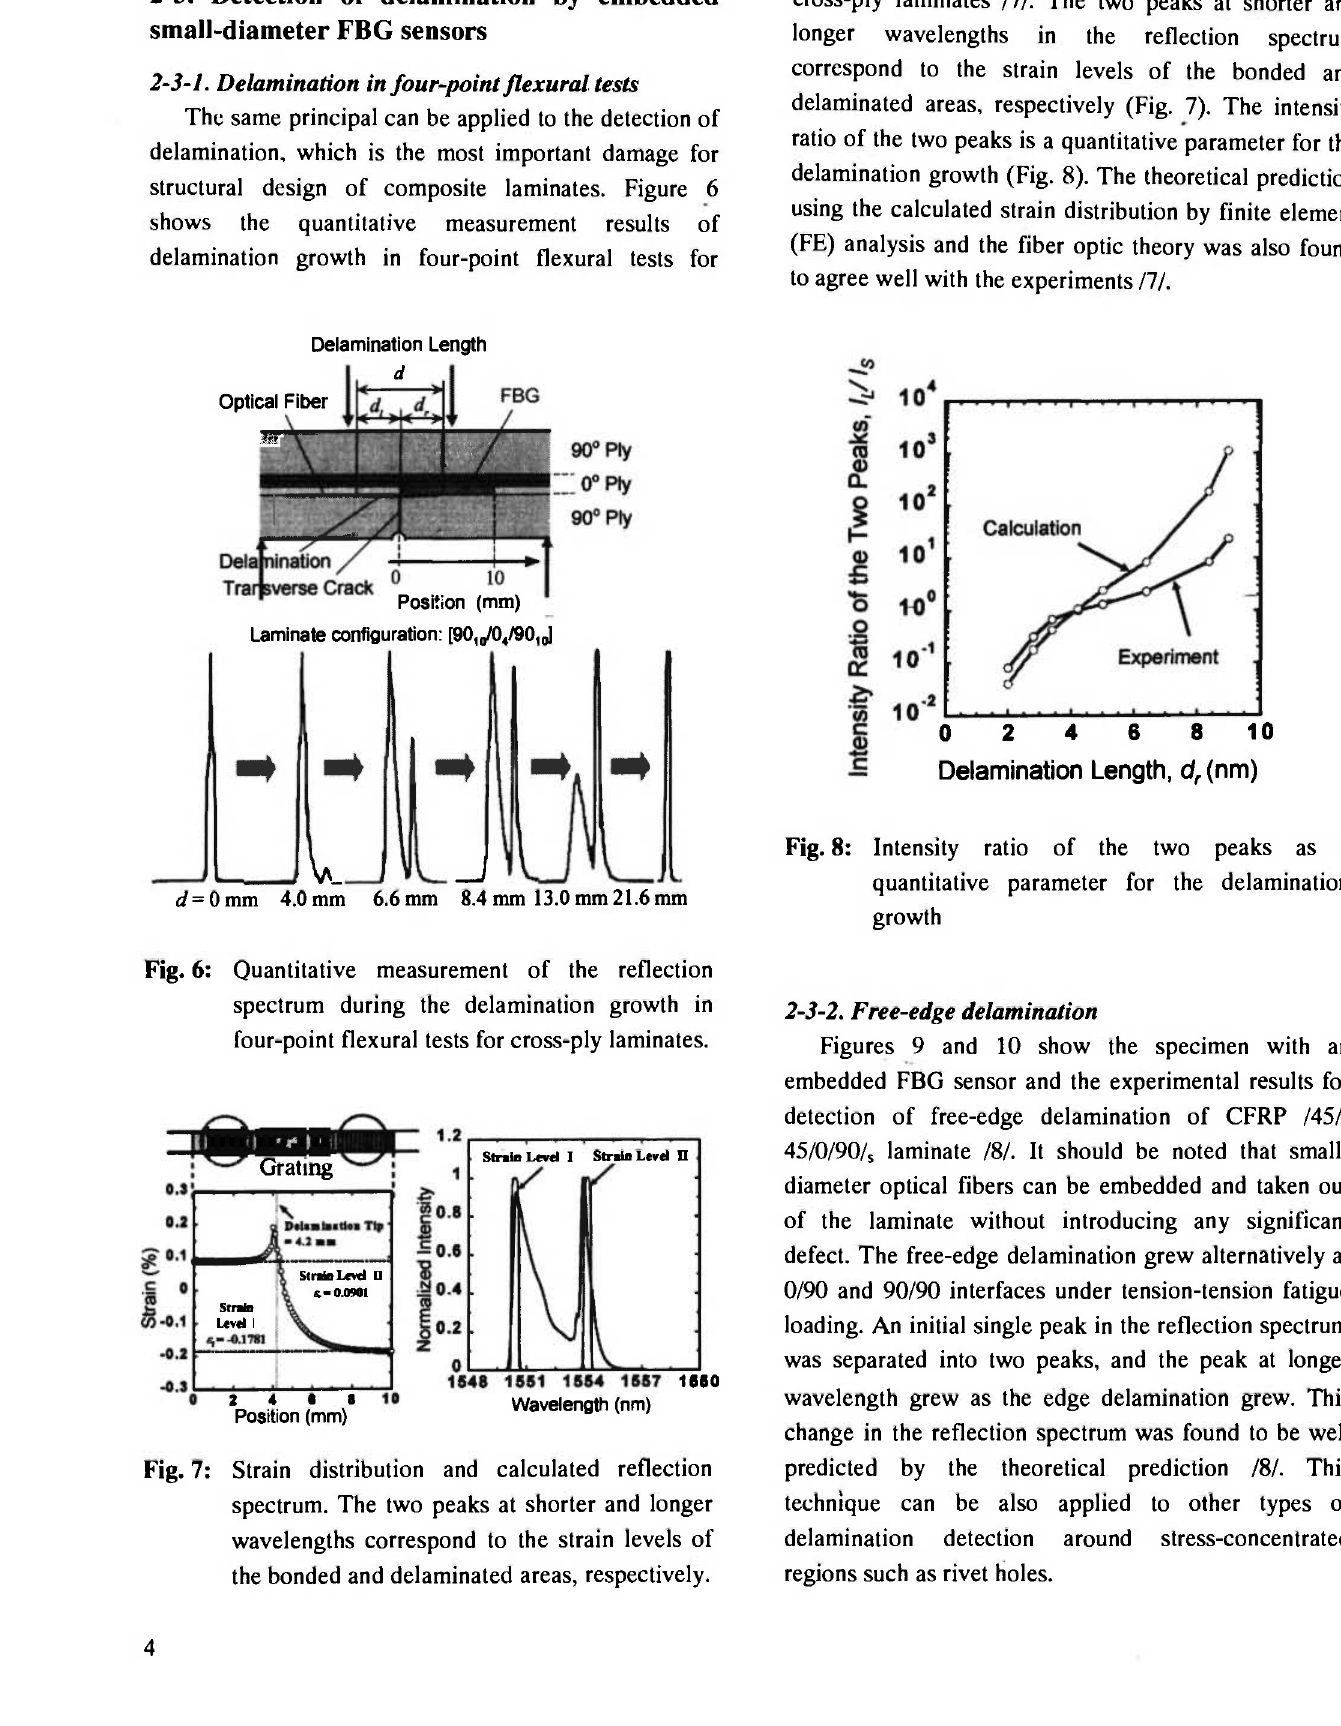
Fig. 6: Quantitative measurement of the reflection spectrum during the delamination growth in four-point flexural tests for cross-ply laminates.